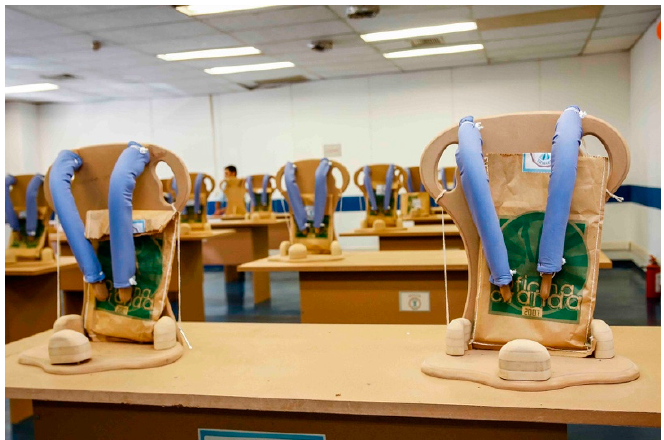
Figure 4. Concluded Ciranda seats during the second day of the Ciranda Workshop.